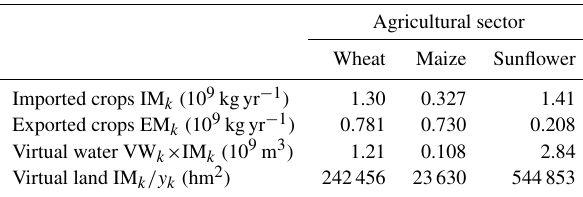
Table 2. Optimal solutions to imported and exported